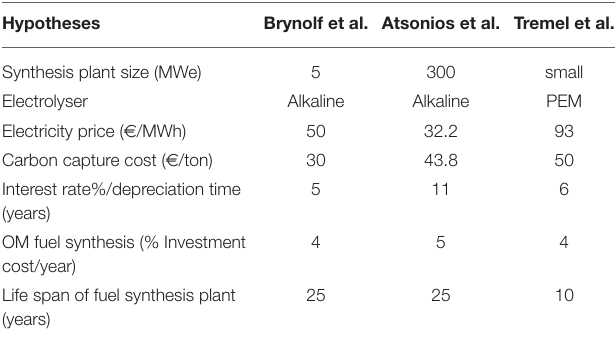
TABLE 6 | Storage and transportation costs—based on a Reuss et al. (2017), b Laborelec (2016), c Bartels (2008), d Connolly et al. (2016), e Estimated, f Rivarolo et al.